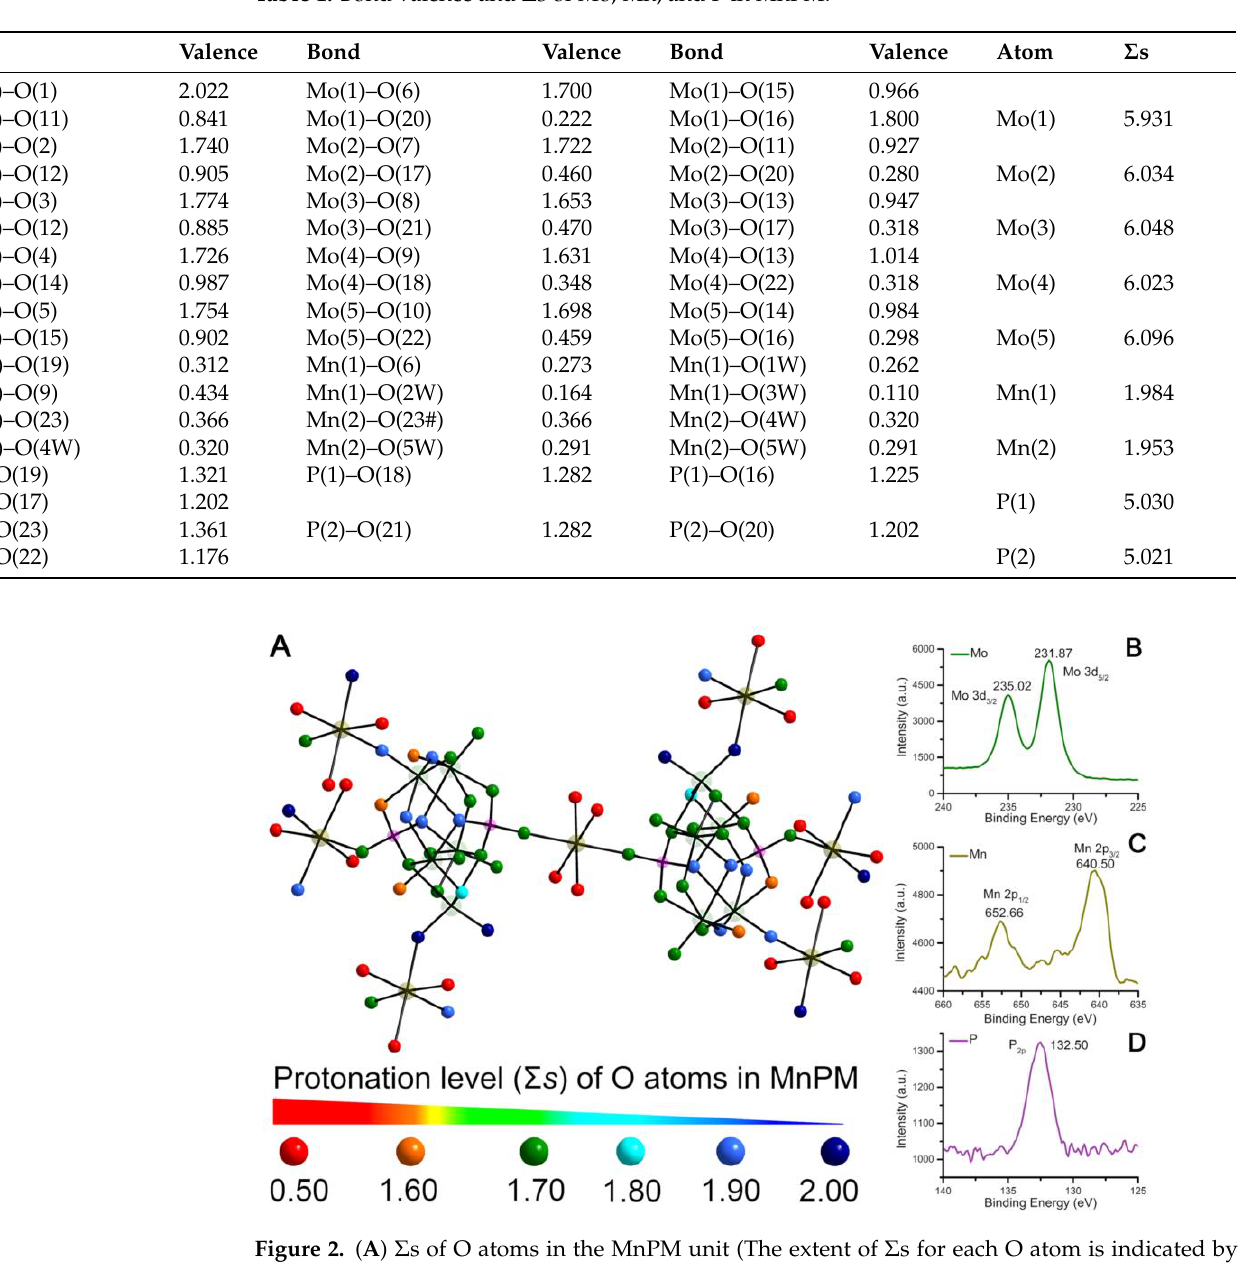
Figure 2. ( A ) Σ s of O atoms in the MnPM unit (The extent of Σ s for each O atom is indicated by different colors). X-ray photoelectron spectrum (XPS) and the fitted curves of Mo ( B ), Mn ( C ), and P ( D ) in MnPM.